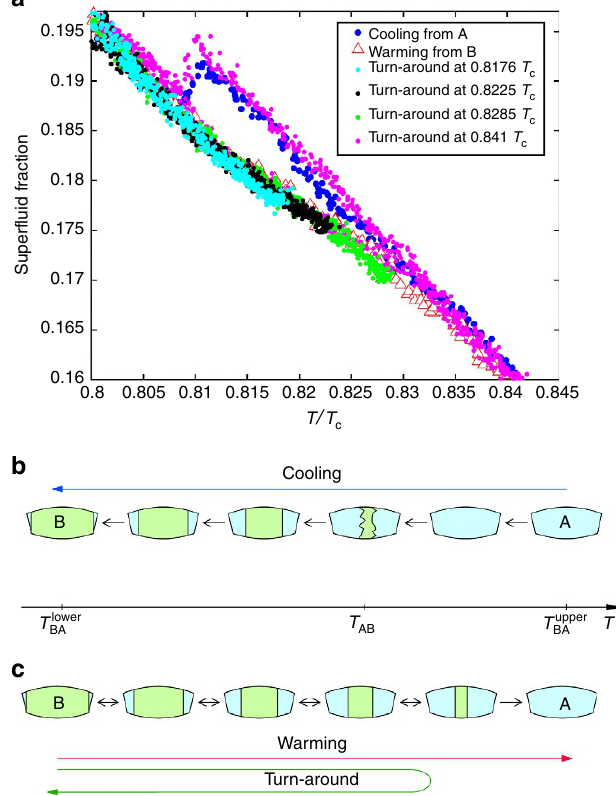
Figure 5 | Traversal of the A–B transition. ( a ) Superfluid fraction on different trajectories through the A–B transition region at 1.4bar. ( b , c ) Schematic depiction of the distribution of the A and B phases in the cavity in the presence of bowing. ( b ) The A phase supercools down to T AB , where the sample converts into the B phase at once. For 1.4 and 0.1bar T AB occurs below T lower . At 2.5, 3.6 and 5.6bar, T AB occurs above T lower and the BA BA transformation from A to B phase continues on cooling below T AB till the B phase fills the annular cavity at T lower with the exception of the tapered BA edges (see Supplementary Figure 2), which remain in the A phase due to strong confinement. ( c ) These edges serve as seeds of the A phase at the gradual B–A transition on warming via the A/B coexistence state. If the sample is cooled again in a turnaround from the coexistence state, the A to B transition also occurs gradually, following the route of the warming transition, indicating that on warming the equilibrium transition is